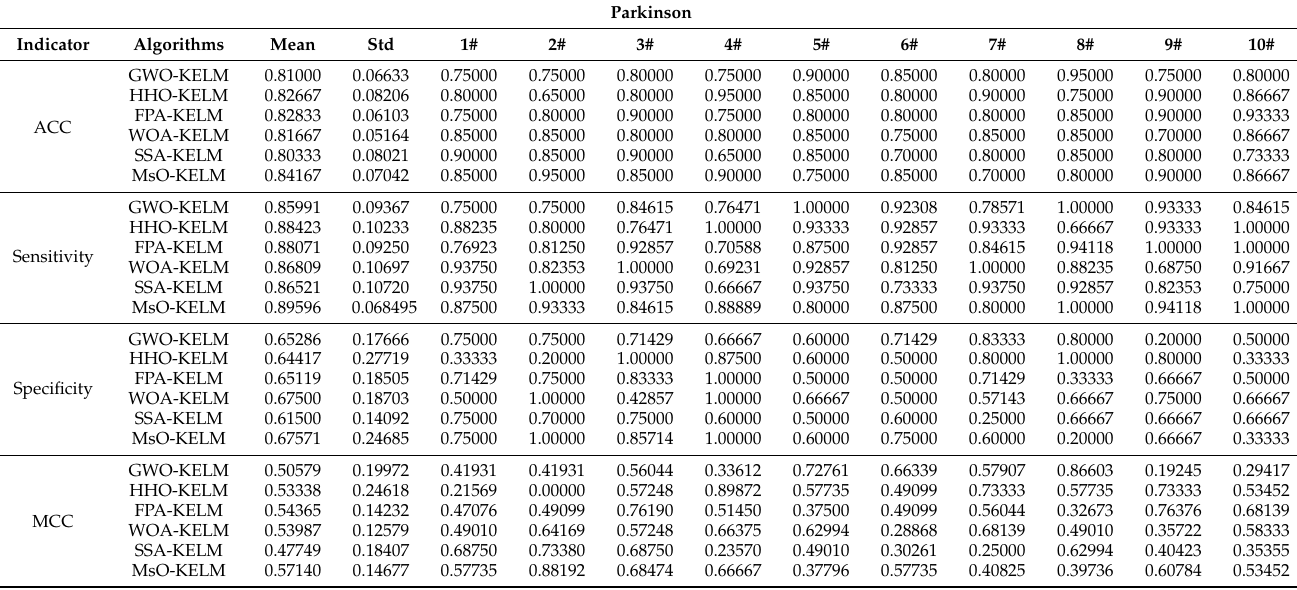
Table 7. The prediction results on disease dataset Parkinson.